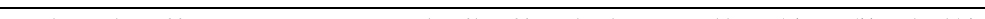
Fig. 4 In silico analysis of furrow invagination. a – c Spatial pro fi les of force distributions in wild-type ( a ), neur ( b ), and Brd ( c ) embryos represented as a one- dimensional epithelium at the bottom of each panel (color code: ectoderm, gray; mesectoderm, dark orange; lateral mesoderm, light orange; central mesoderm, yellow; dorsal is at ± 180°, ventral at 0°). Apical forces (Gaussian red curve) and lateral forces (Sigmoid blue curve) are maximal in ventral cells whereas basal forces (green) are maximal in the ectoderm (at the indicated time points). Two time points are given for Brd embryos ( c ) to show the increase of apical forces in the ectoderm. The magnitude of the forces operating in silico is set by the viscosity of the cellular cytoplasm. For the sake of simplicity, the range of these forces was normalized per unit of viscosity. Consequently, forces range between 0 and 1, the latter being reached in the apical mesoderm. See Supplementary Fig. 6h – l for normalized experimental values in wild-type embryos. d – f Time evolution of force distribution in wild-type ( d ), neur ( e ), and Brd ( f ) embryos. To simulate neur embryos ( e ), apical (red) and lateral (blue) force distributions in the wild-type mesoderm (0°) were modi fi ed such that apical forces took longer to reach a maximum value weaker than their wild-type counterparts (shown in black) and that lateral forces were shifted in time relative to the wild-type ones (gray). To simulate Brd embryos ( f ), apical forces in the ectoderm ( ± 180°) were increased to compete with those set in the mesoderm (0°) at furrow invagination ( t = 21 min). g – i Time trends of apical constriction (central mesoderm area, blue; arbitrary units), furrow invagination (orange; arbitrary units) and ventral cell lengthening (green) in wild-type ( g ), neur ( h ), and Brd ( i ) embryos. See Supplementary Fig. 6g for experimental values. j Selected in silico views of wild-type, neur , and Brd embryos at various time points. Simulations reproduced the in vivo phenotypes. See Supplementary Movies 4 and